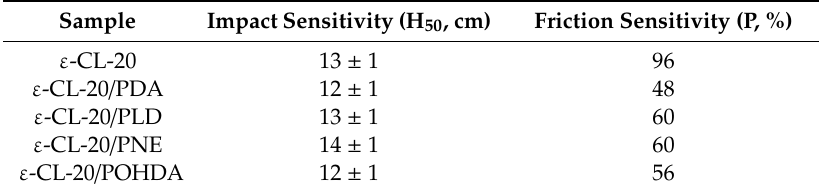
Table 4. Impact and friction sensitivity of ε -CL-20 and di ff erent